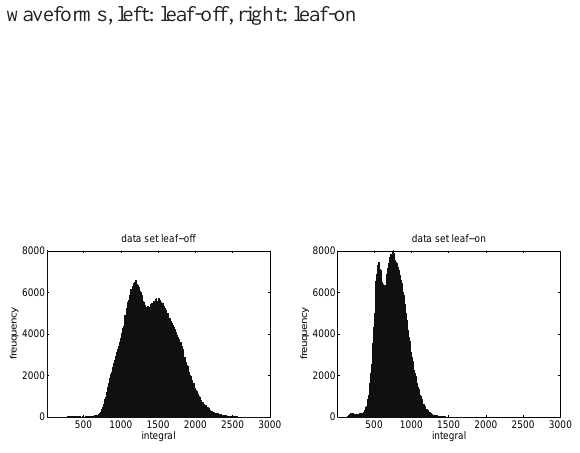
Figure 10: Histogramm of the integrals of all waveforms, left: leaf-off, right: